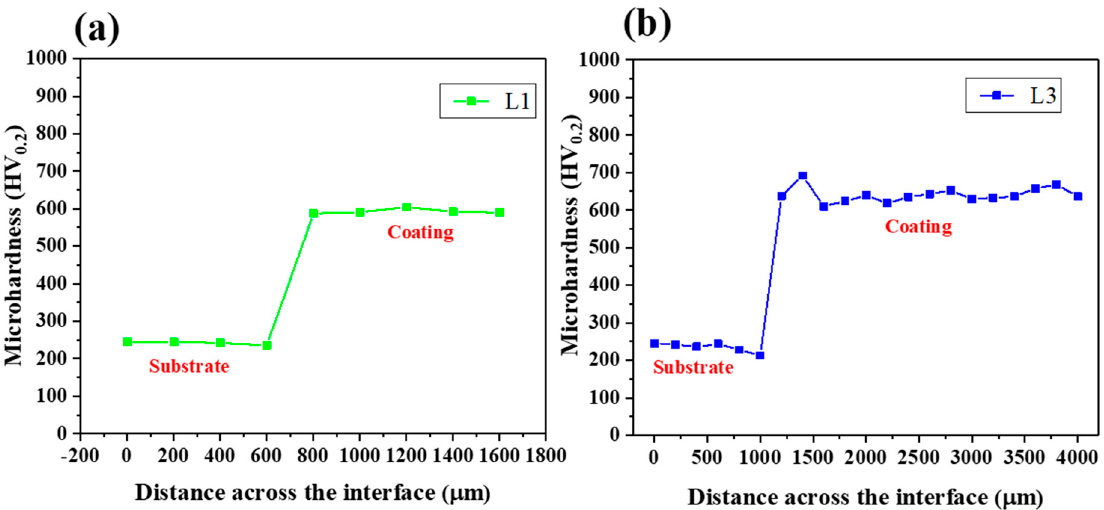
Figure 8. Microhardness profile of laser cladded cross section: ( a ) L1, ( b ) L3. The dry sliding friction and wear test with a sliding friction load of 10 N and a wear time of 1800 s was conducted to evaluate the friction performance of the substrate and the coatings. The obtained friction coefficient curve of the substrate and the coatings and the relevant histogram of the average friction coefficient calculated from the friction coefficient curve are shown in Figure 9a,b, respectively. As shown in Figure 9a, all samples reach a high limited value of the friction coefficient before it stabilizes. This is because in the early stage of sliding friction, the material is continuously sheared, and the deformation layer is continuously accumulated. And the accumulated deformation layer is continuously washed to ensure the smooth progress of the experiment, so the friction coefficient is increased [39]. In addition, since the hardness of the substrate is relatively lower, the deformation layer accumulated in the sliding friction experiment is easier to be washed, so the friction coefficient of the substrate tends to be stable earlier than that of the coating. As the sliding friction experiment continues, the friction coefficient of the substrate shows a slight decrease. Kumar believes that this is because the transfer of materials during the sliding friction increases the carbon concentration on the surface of 316L SS, thus promoting the formation of the friction film [40]. It can be concluded from Figure 9b that the average friction coefficient of different samples meets the substrate (0.53 ± 0.02) > sample L1 (0.47 ± 0.05) > sample L3 (0.44 ± 0.03), indicating that nickel-based alloy coating can effectively improve the wear resistance of 316L SS, and the improving effect of multi- layer cladding is better than that of single-layer cladding.